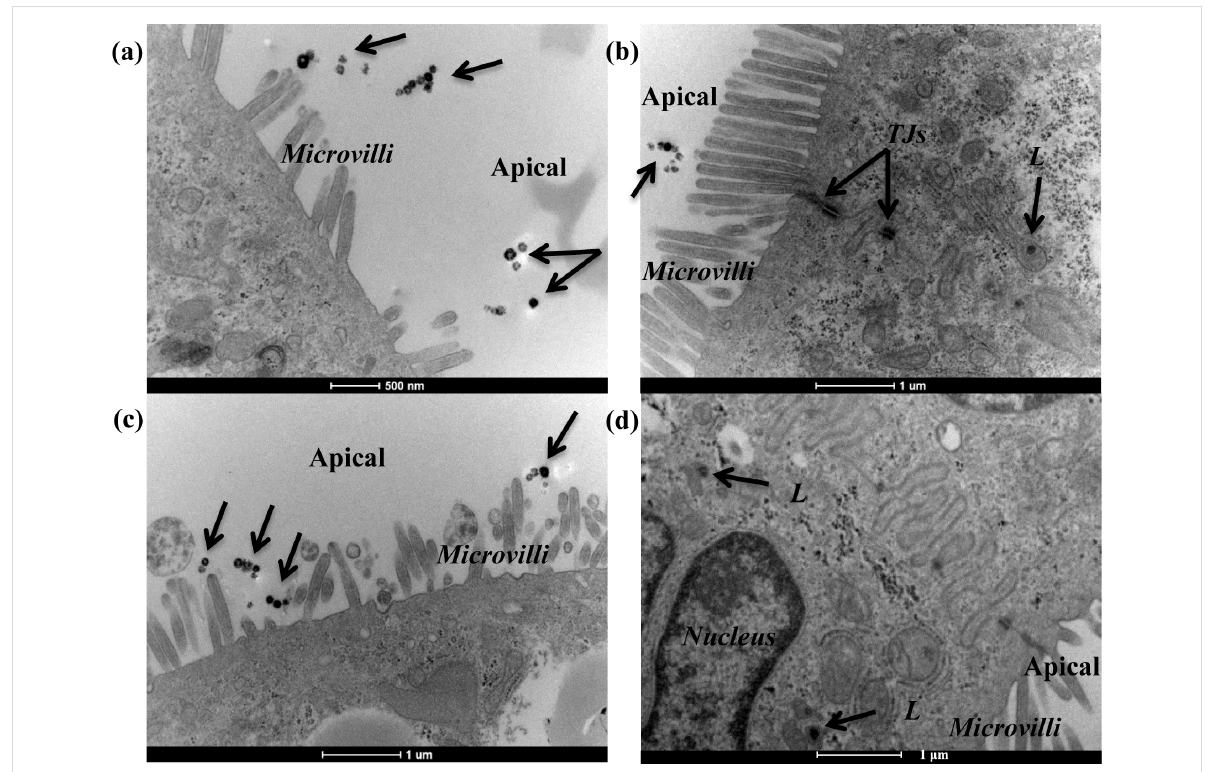
Figure 4: Transmission electron micrographs of Caco-2 barriers after exposure to 150 nm SiO 2 -NPs. Caco-2 barriers cultured for 21 days were exposed for 9 h to 100 µg/mL 150 nm SiO 2 -NPs dispersed in (a,b) the absence of serum, and (c,d) the presence of 10% FBS. The arrows indicate extracellular NPs and some NPs inside vesicles along the endolysosomal pathway. Abbreviations: L , lysosome; TJs , tight